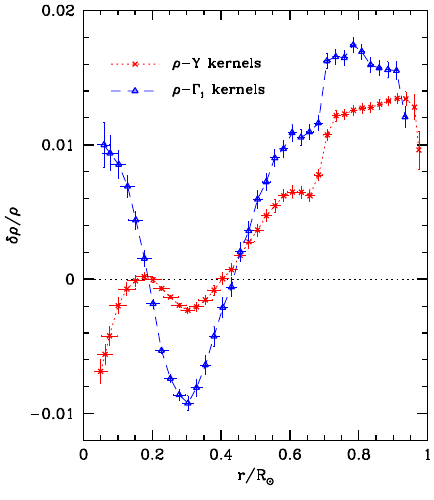
Fig. 15 The relative difference in the density between the Sun and reference model S (Christensen-Dalsgaard et